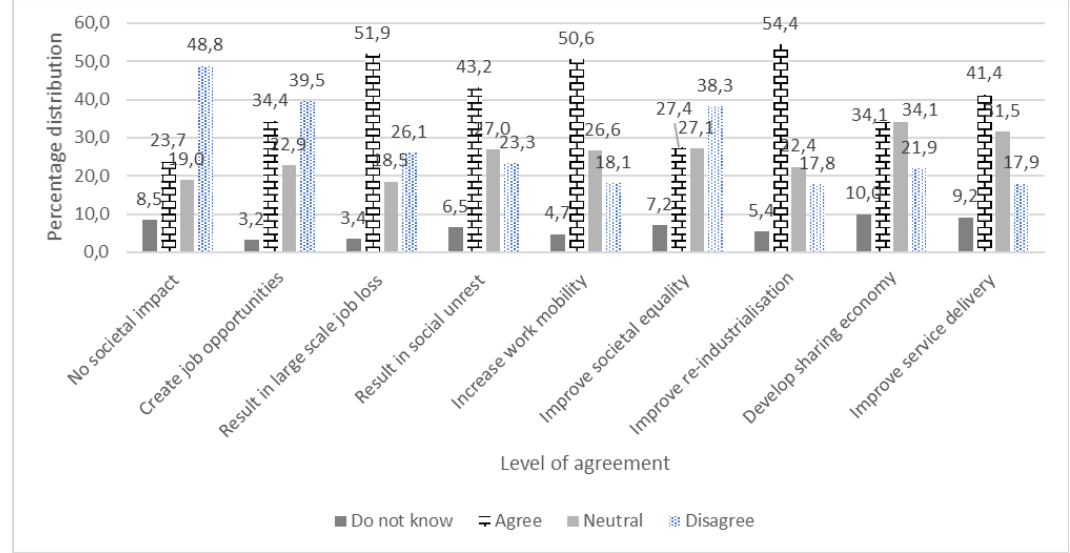
Figure 1 : Level of agreement with nine societal impact factors of the fourth industrial revolution; Source: Authors